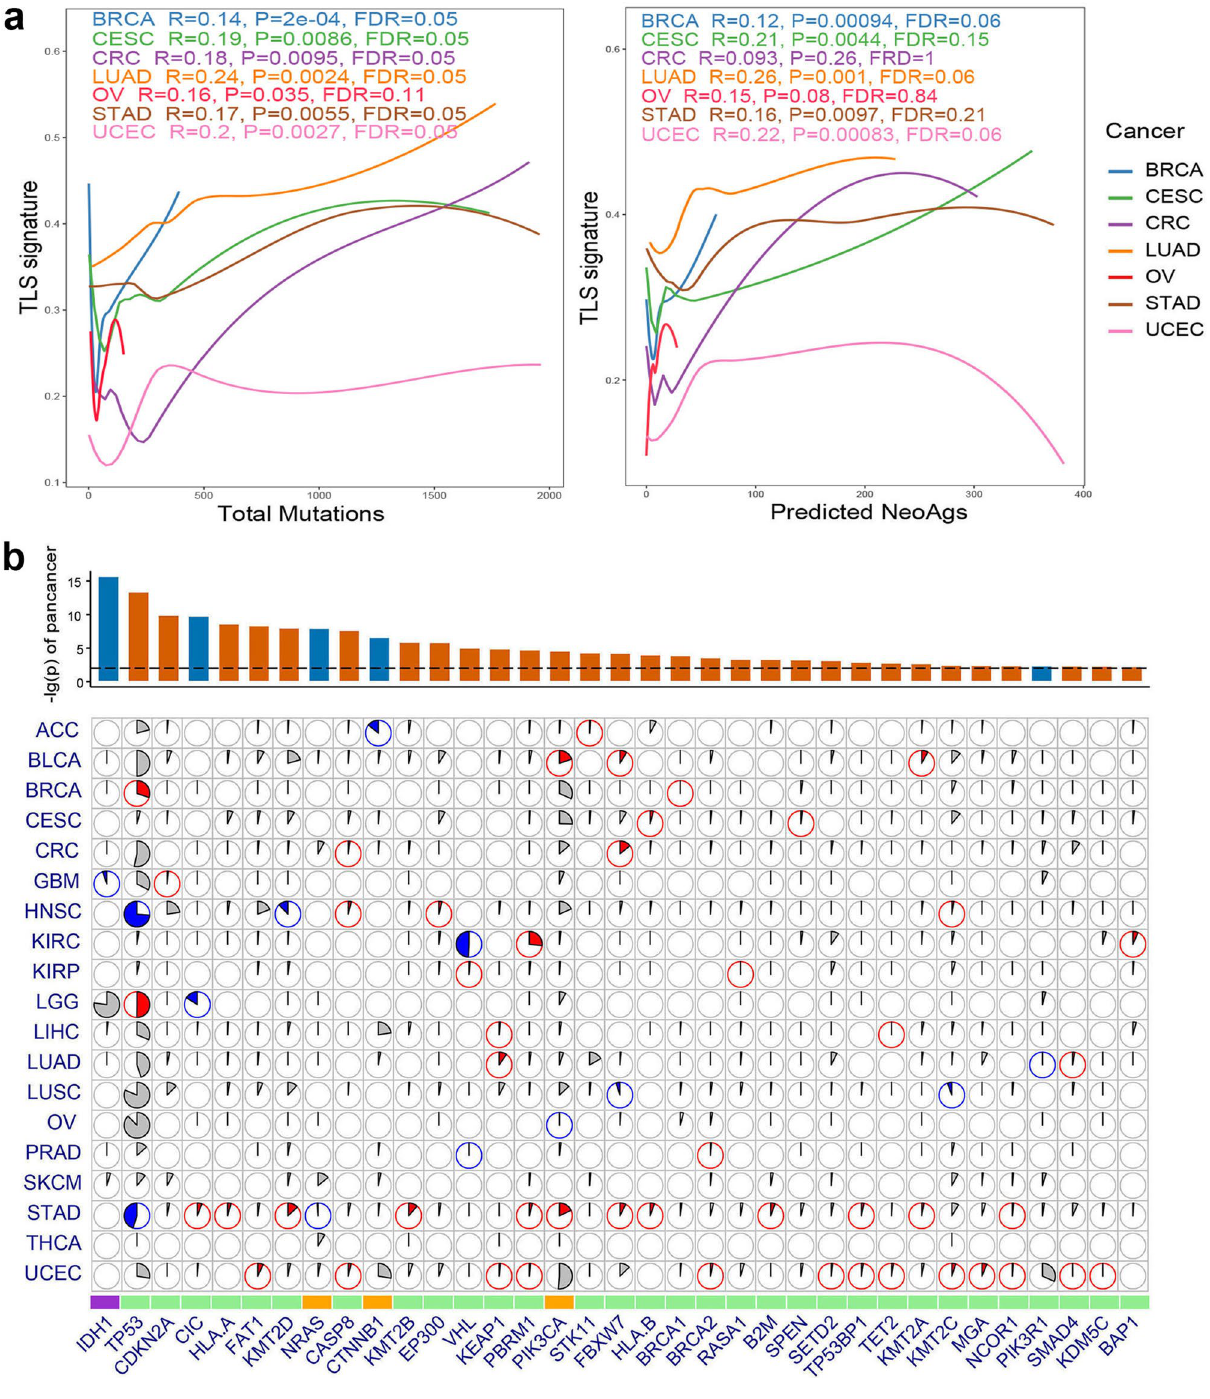
Figure 4. Correlation of TLS scoring with mutation/neoantigen loads and driver gene mutations. ( a ) Local regression curves showing significant relationships of TLS scoring with total mutation count (left) and predicted neoantigen load (right) in seven tumor types; R value, p value and false discovery rate (FDR) of Spearman rank correlation analysis of each tumor type (denoted as lines in different color) were presented; curves span the 5th to 95th percentile of the mutation/neoantigen counts variable; colors correspond to tumor type and are the same in two graphs. ( b ) Driver gene mutations that associated with increased or decreased expression of TLS signature. Only genes showing significance (adj. P < 0.01, red for positive, blue for negative association) for non-silent mutation association with TLS scoring in pan-cancer dataset are shown in the top bar plot, with the value of y axis representing log10( p value), and the dashed line indicating threshold P = 0.01. The pie plots below demonstrated association between TLS scoring and mutation of each driver gene in different tumor types ( P < 0.05, red for positive, blue for negative and gray for non-significant association). The wedges with color represent the share of samples exhibiting driver